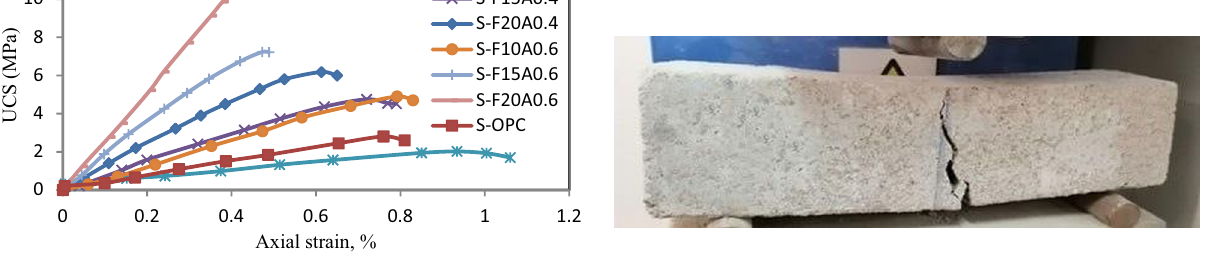
Figure 3: Uncon fi ned stress – strain behavior.